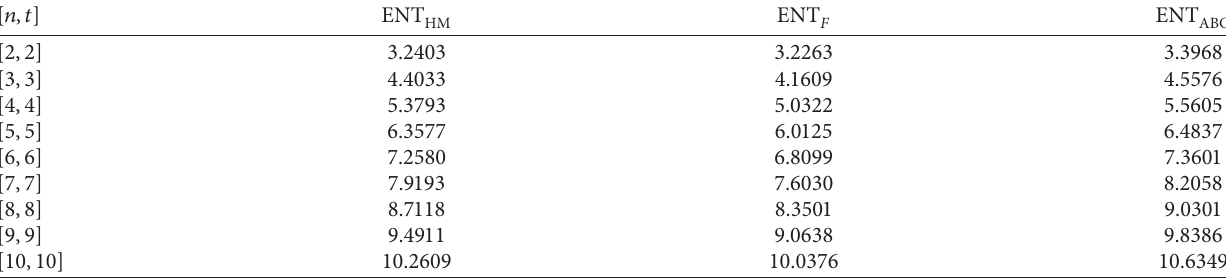
, ENT F , and ENT ABC for CBT ( t ) ⊙ P n . HM